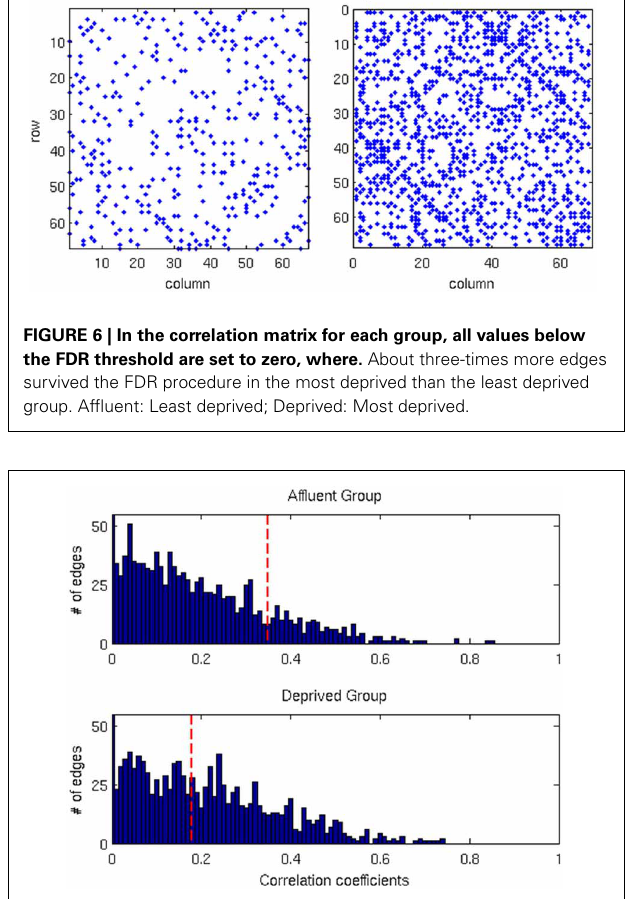
FIGURE 7 | The distributions of correlation coefficients for both groups. The vertical red lines are the FDR threshold values for each group. Affluent: Least deprived; Deprived: Most deprived.